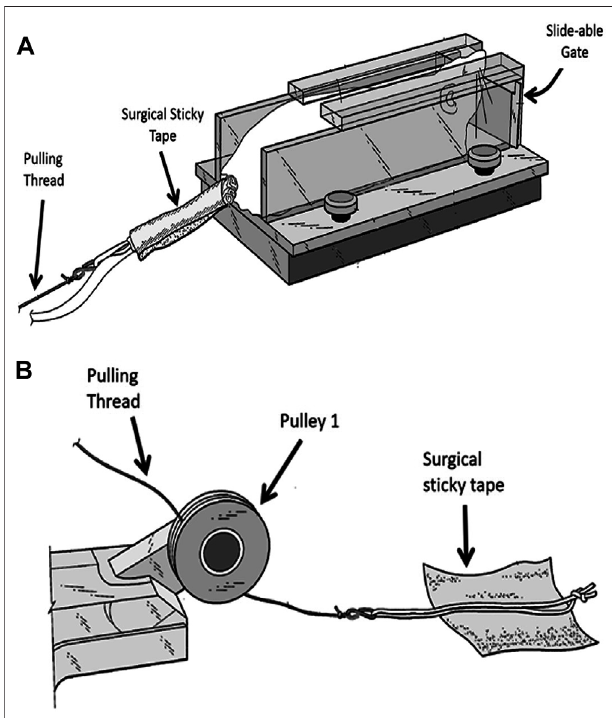
FIGURE 2 | Securing the animal to the weight stack. (A) A rope is secured to rat ’ s tail by wrapping the sticky tape around the tail. (B) A soft cotton rope placed inthemiddle ofasquareshaped stickyhypo-allergictape. Twoedgesofthetapearefoldedtoalloweasyremovalofthestickytape at the end of the